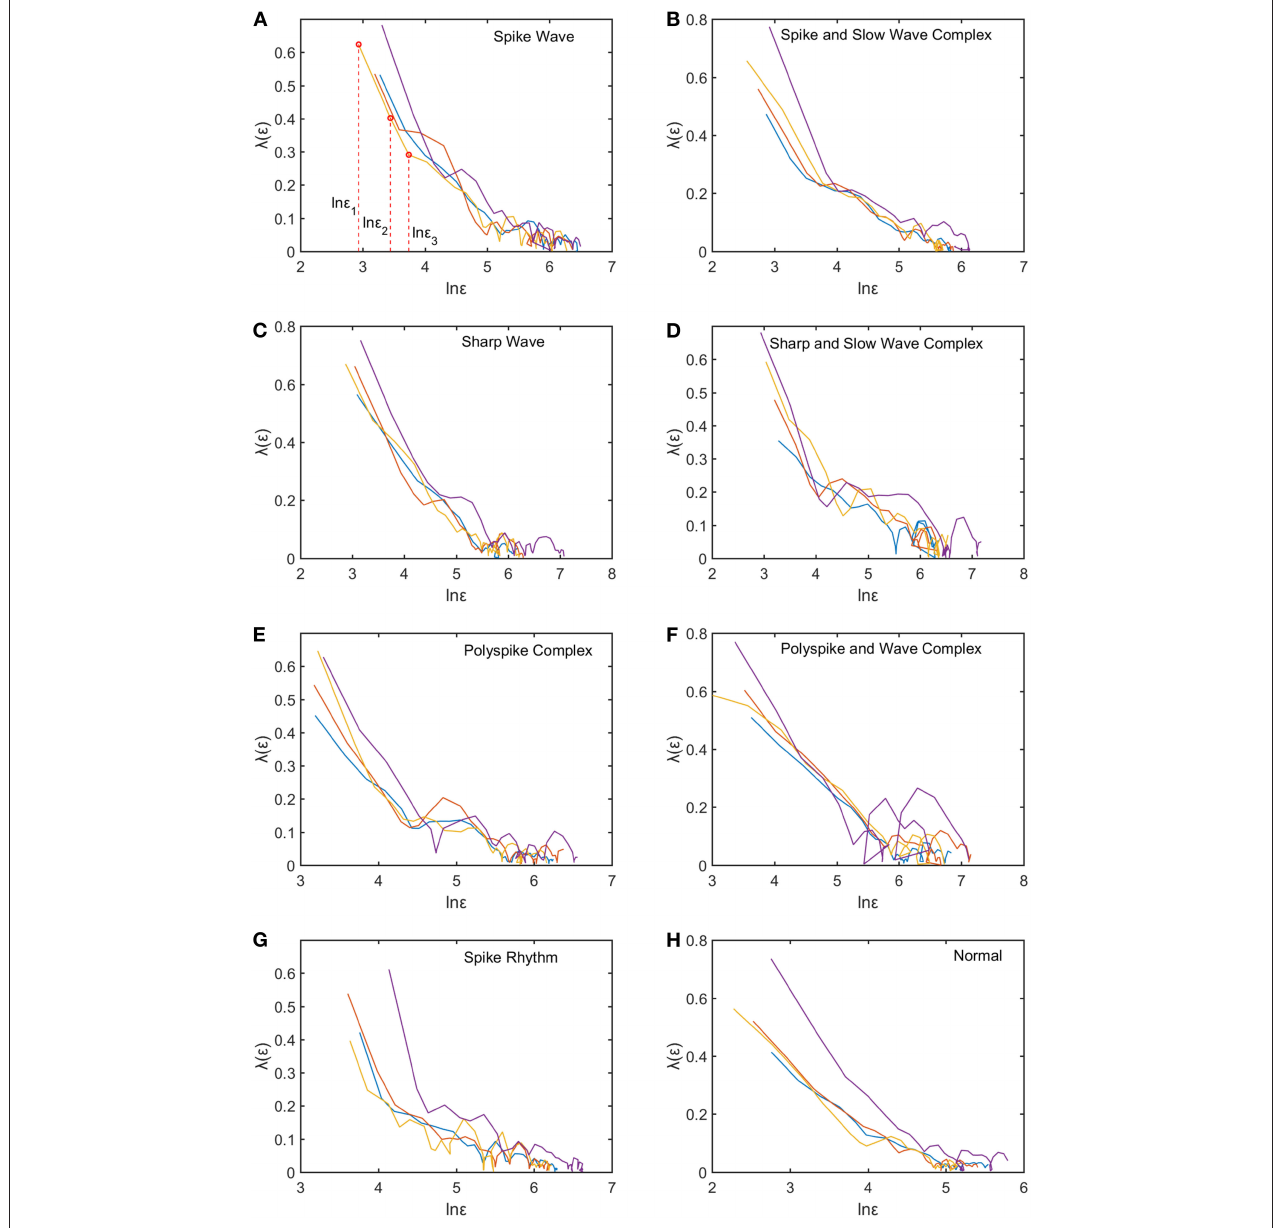
FIGURE 4 | Typical λ ( ǫ ) vs. ln ǫ curves for epileptiform discharges and normal EEG. The four curves represented in four different colors correspond to the error growth curves shown in Figure 3 . (A–H) illustrates the different between the seven types of epileptiform discharges (spike wave, spike and slow wave complex, sharp wave, sharp and slow wave complex, polyspike complex, polyspike and slow wave complex, spike rhythm discharges) and normal